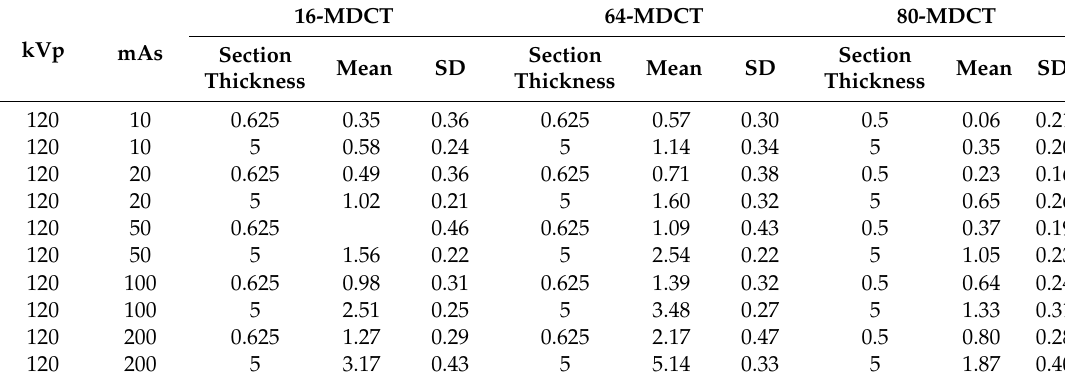
Table 4. Mean CNR values of the images at 120 kVp. The mean values were obtained by averaging three identical exposures.